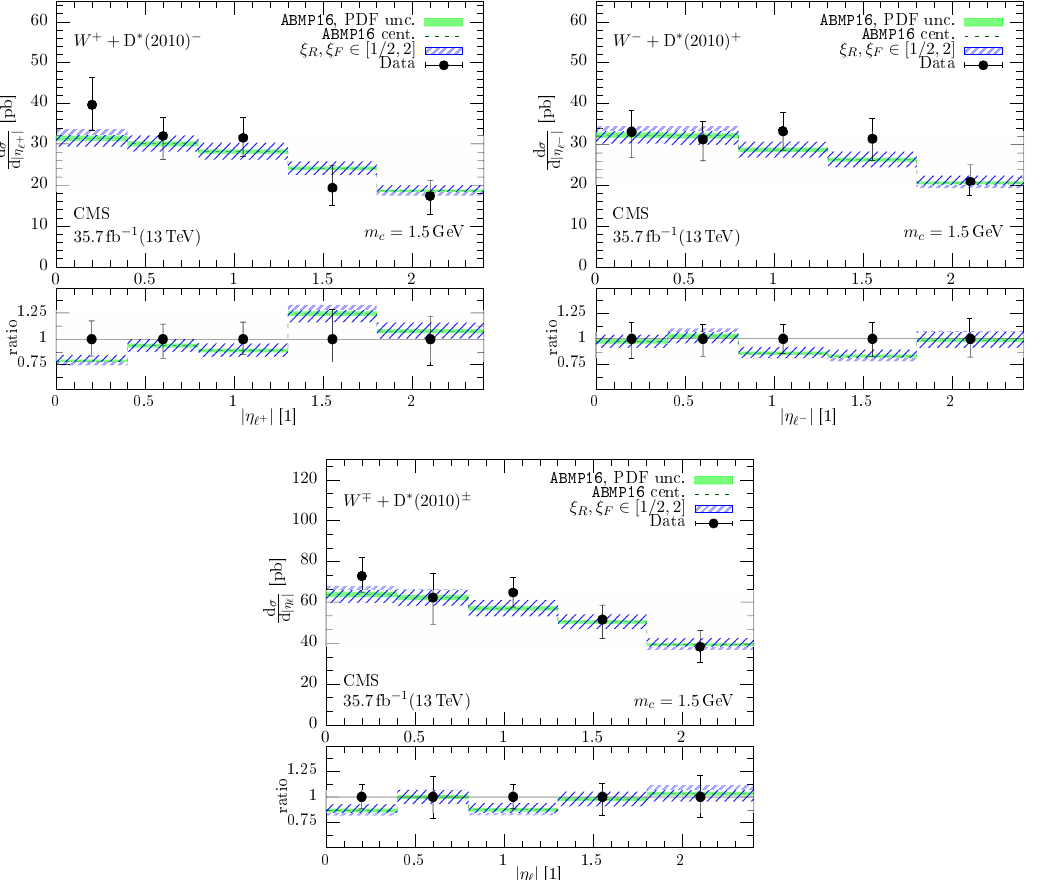
Figure 3 . Difference of the differential cross-section for W + D ∗ (2010) -meson production, with ( − ) W ± → µ ∓ ν µ , where the hardest central µ and the D ∗ (2010) -meson have charge of opposite sign and that where the µ and the D ∗ (2010) -meson have charges of the same sign, as a function of the absolute value of the pseudorapidity of the hardest µ . The three panels refer respectively to the case of µ + , µ − and their sum. Theoretical predictions at NLO + SMC accuracy, obtained by PowHel + PYTHIA8 are compared to experimental data from the CMS collaboration [22]. 7-point ( µ R , µ F ) scale and PDF uncertainty bands, computed from the 30 members of the ABMP16_3_NLO PDF set, are reported by shaded (blue) and solid (green) bands, respectively. As further input of PowHel , we consider 2-loop α S evolution, α S ( M Z ) = 0 . 1066 consistent with the PDF set, and m c = 1 . 5 GeV. The predictions include parton shower, hadronization, MPI and beam remnant effects according to the PYTHIA8 Monash tune. See text for more